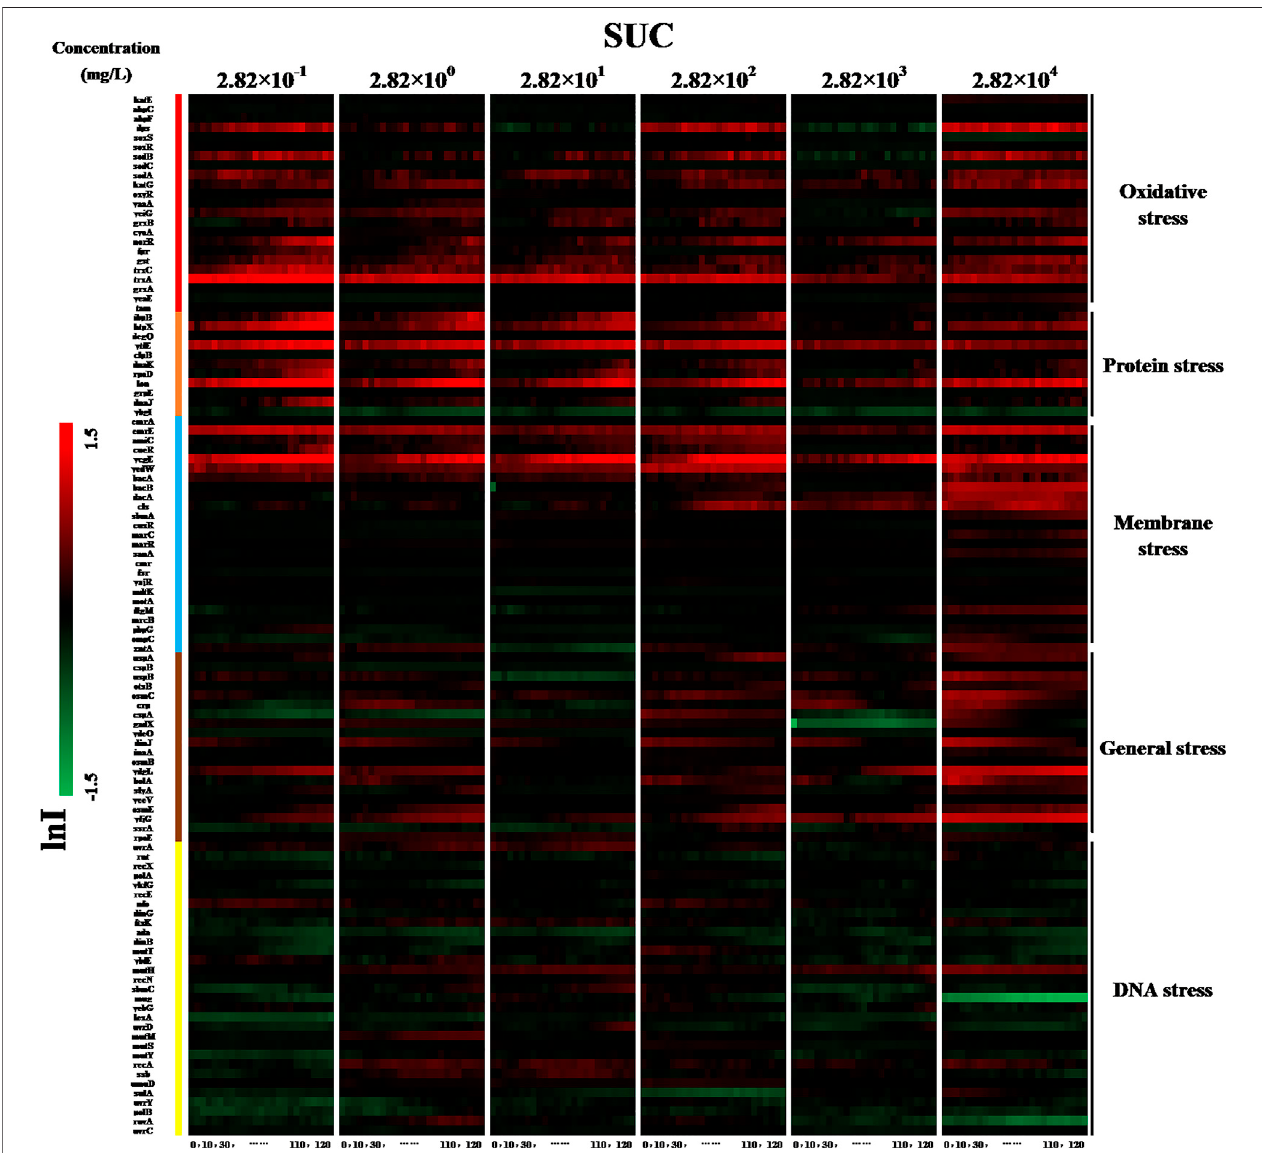
FIGURE 5 | Real-time gene expression pro fi les at different SUC concentrations. Red and green indicates upregulation and downregulation, respectively; values exceeding ± 1.5 are according to ± 1.5.